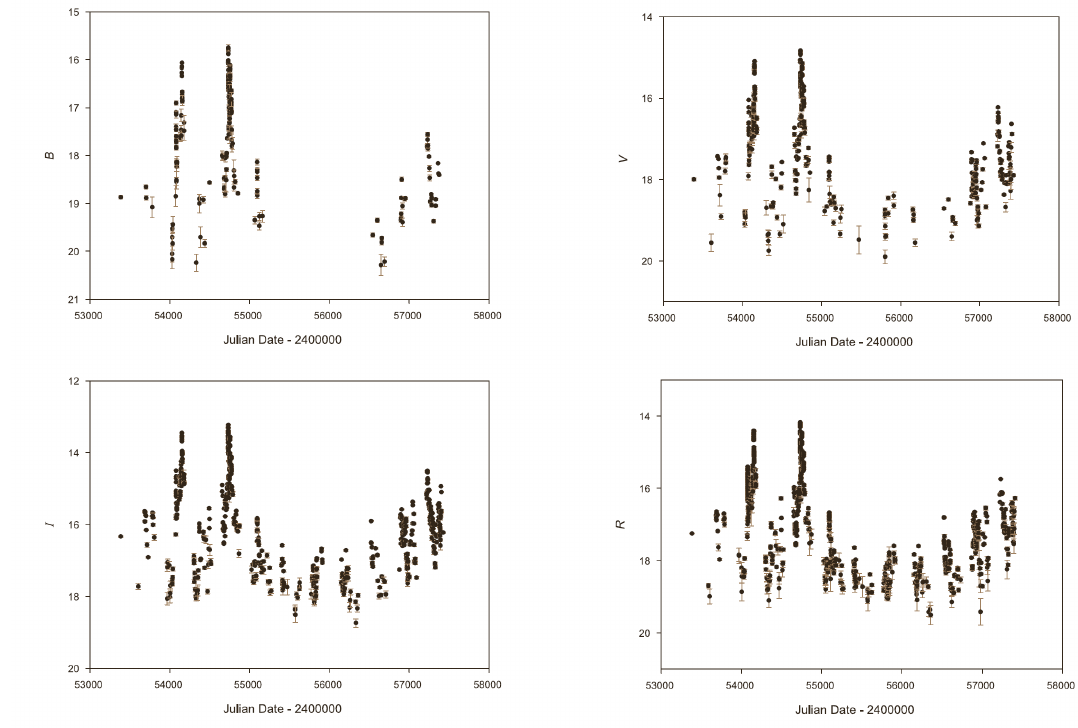
Figure 2. Light curves in filters B , V , R c , I c for 2006–2016.